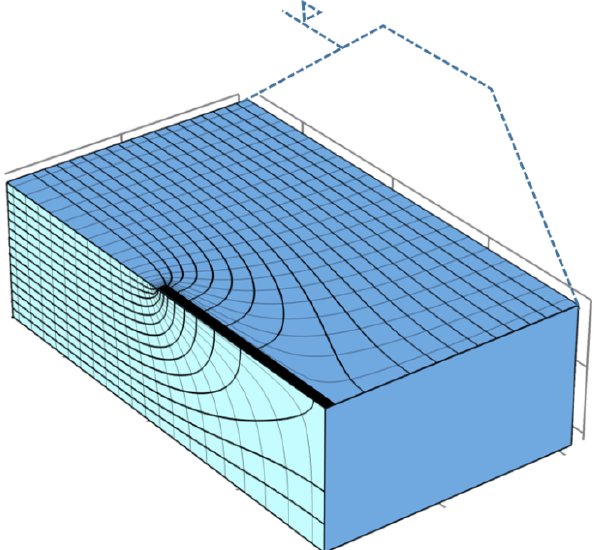
Figure 12. Finite element simulation of a thermal front propagating in the foundation of the test dike for a constant hydraulic load of 3m, constant inflow temperature of 16 ◦ C and uniform initial tem- perature T = 12 ◦ C. On the x axis the distance from the inflow point is